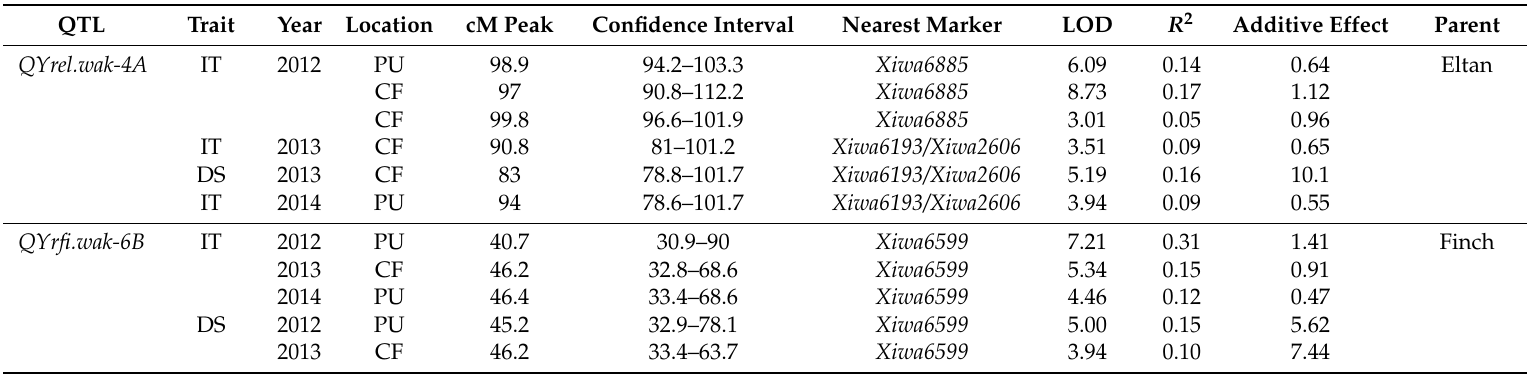
Table 1. Quantitative trait loci (QTL) identified in the Finch ˆ Eltan winter wheat recombinant inbred line mapping population for infection type (IT) and disease severity (DS) of stripe rust in Pullman (PU) and Central Ferry (CF), WA, across three